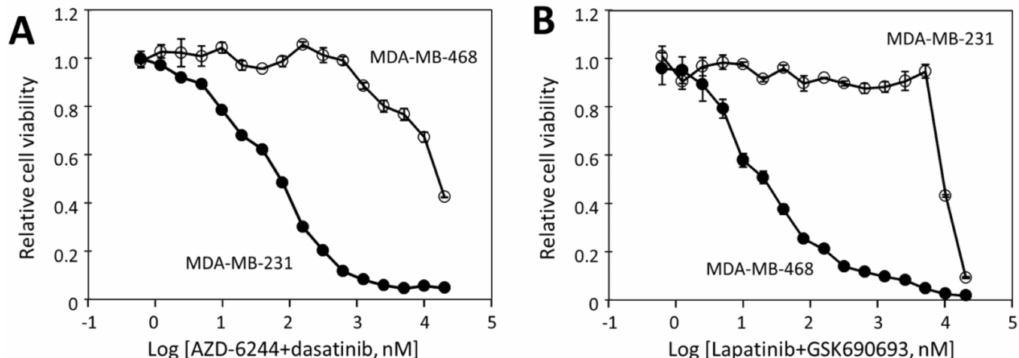
Figure 5. Cell line-specific inhibition of MDA-MB231 cell viability by dasatinib / AZD-6244 combination and of MDA-MB-468 cell viability by lapatinib / GSK690693 combination. ( A ) inhibition of MDA-MB-231 and MDA-MB-468 cell viability by the combination of AZD-6244 and dasatinib; ( B ) inhibition of the two cell lines by the combination of lapatinib and GSK690693. The results are representative of two independent experiments of